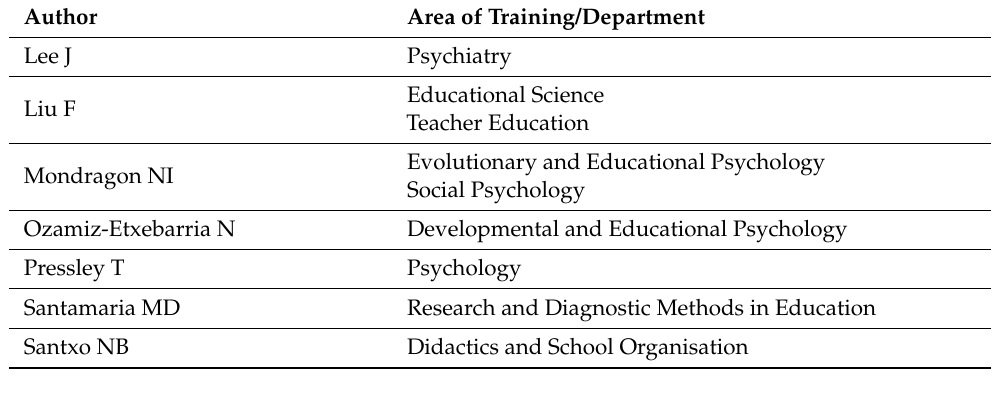
Table 2. Most productive authors by area of training ( ≥ 3 Recs).